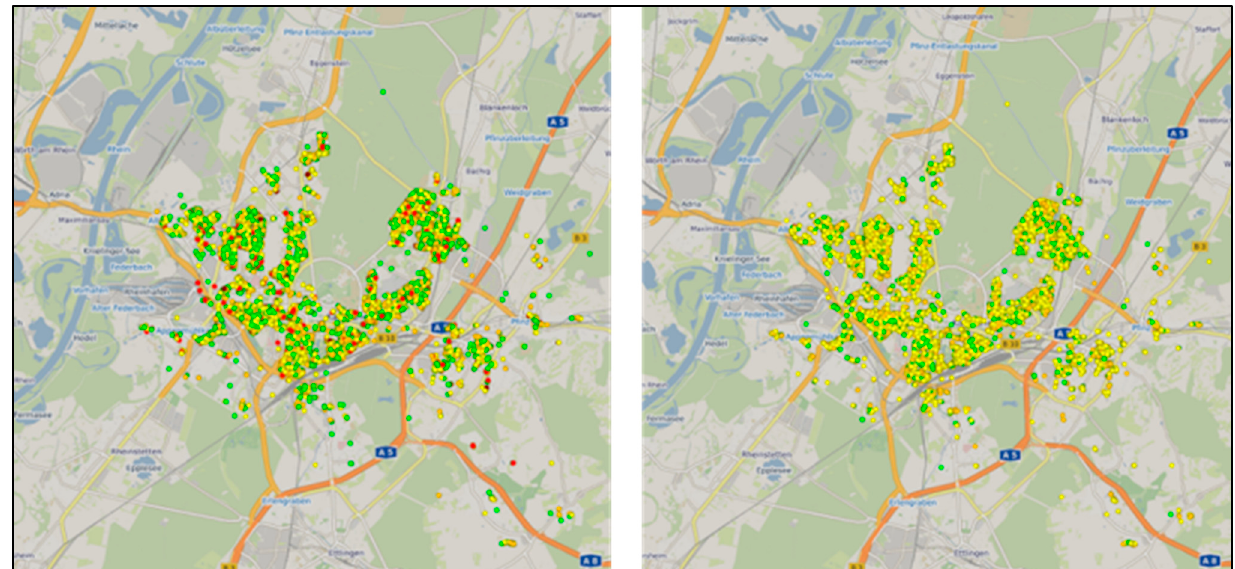
Figure 3. Citizens’ attitudes regarding wind power ( left ) and photovoltaic plants ( right ) in the first global survey. The values range from 1 (dark red; negative attitude) to 5 (green; positive attitude). We assume that citizens have a more positive attitude towards photovoltaic plants than towards wind turbines, as reflected by more red and dark red dots in the left-hand image than in the right-hand image.